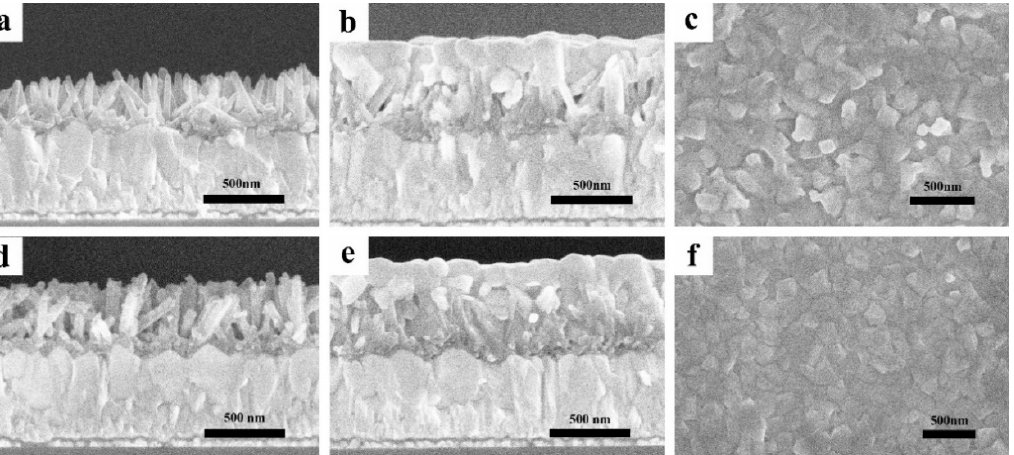
Figure 2. Cross-sectional SEM images of ( a ) bare TiO 2 NR film; ( b ) bare TiO 2 NR/perovskite film; ( d ) TiO 2 NR/brookite NP film; ( e ) TiO 2 NR/brookite NP/perovskite film; ( c , f ) are the top-view SEM images of bare TiO 2 NR/perovskite film and TiO 2 NR/brookite NP/perovskite film. Atomic force microscopy (AFM) was used to investigate the surface roughness of the bare TiO 2 NR film and TiO 2 NR/brookite NP film, which are shown in Figure 3. The root-mean-square (RMS) surface roughness of the bare TiO 2 NRs film is 21.2 nm, which is smaller than that of the TiO 2 NR/brookite NP film (23.8 nm). The increased roughness could be attributed to the brookite NPs, which will form a rough surface for PbI 2 to load around the NRs and further form the perovskite layer. Figure 3. Atomic force microscopy (AFM) images of ( a ) bare TiO 2 NR film; ( b ) TiO 2 NR/brookite NP film. TEM and HRTEM were used to characterize the morphology and crystal structure of the TiO 2 NR and TiO 2 NR/brookite NPs. As shown in Figure 4a,b, the bare NR possesses a smooth surface with a length of around 400 nm. Moreover, the lattice fringes of bare NRs with an interplanar spacing d = 0.324 nm, which corresponds to the (110) plane of rutile TiO 2 , can be observed in Figure 4b. This pure rutile phase indicates that the NR is a single-crystal structure with high crystallinity, which could provide direct access for photo-generated electrons to transport from the perovskite layer to the electron collecting layer. Apart from the bare rutile NR, the surface of the NR in Figure 4c is covered by NPs with a thickness of 5 nm. These NPs increase the roughness of the NR and offer a nanostructured interfacial contact between perovskite and ETL, which will promote car- rier separation and transport. In addition, we notice that, besides the lattice distances of 0.324 nm, there are also existing lattice spacing values of 0.346 nm and 0.225 nm, which correspond to the (111) plane and (112) plane of brookite TiO 2 (JCPDS No. 29-1360) (Figure 4d). These crystalline planes and lattice spaces demonstrate that TiCl 4 treatment with low-